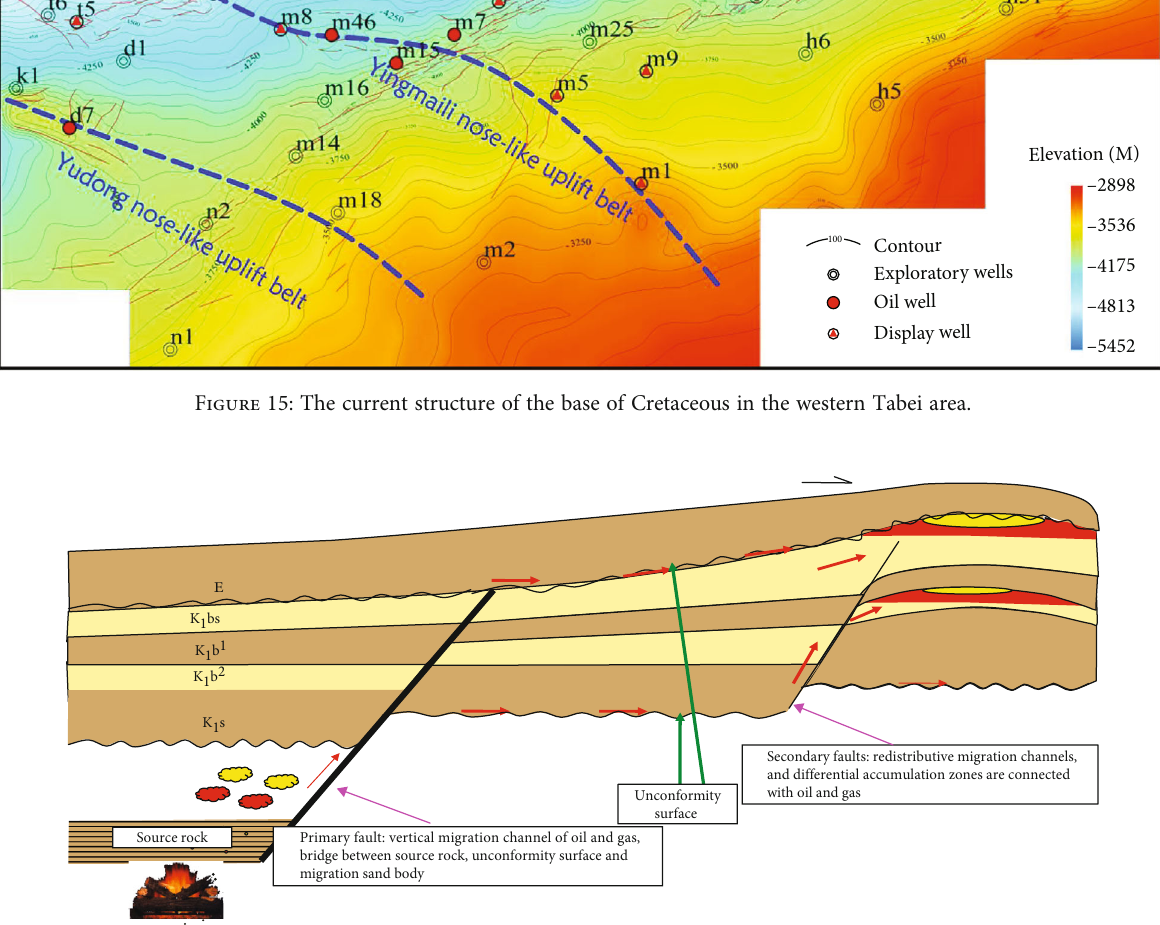
Figure 16: Remote reservoir forming model under complex transport system.